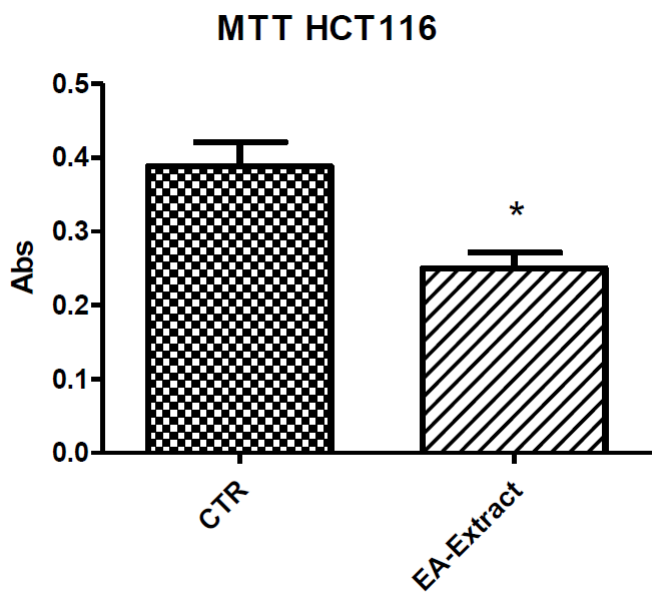
Figure 5. E ff ect of ethyl acetate (EA) A. santonicum extracts (100 µ g / mL) on tumoral HCT116 cell line Figure 5. Effect of ethyl acetate (EA) A. santonicum extracts (100 µg/mL) on tumoral HCT116 cell line viability (MTT test). * p < 0.05 vs. control (CTR) viability (MTT test). * p < 0.05 vs. control (CTR) group.